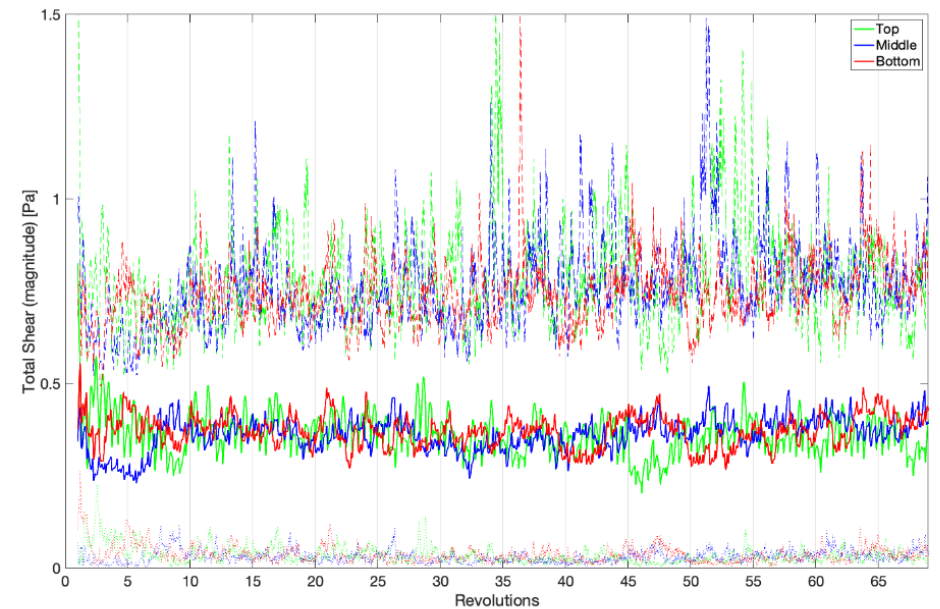
Figure 3. Averages of the total shear stress for the top, middle, and bottom rows of coupons as a function of time. The coupon averages (bold), maximums (dashed), and minimums (dotted) are shown. The average shear stress is area weighted by the element area.